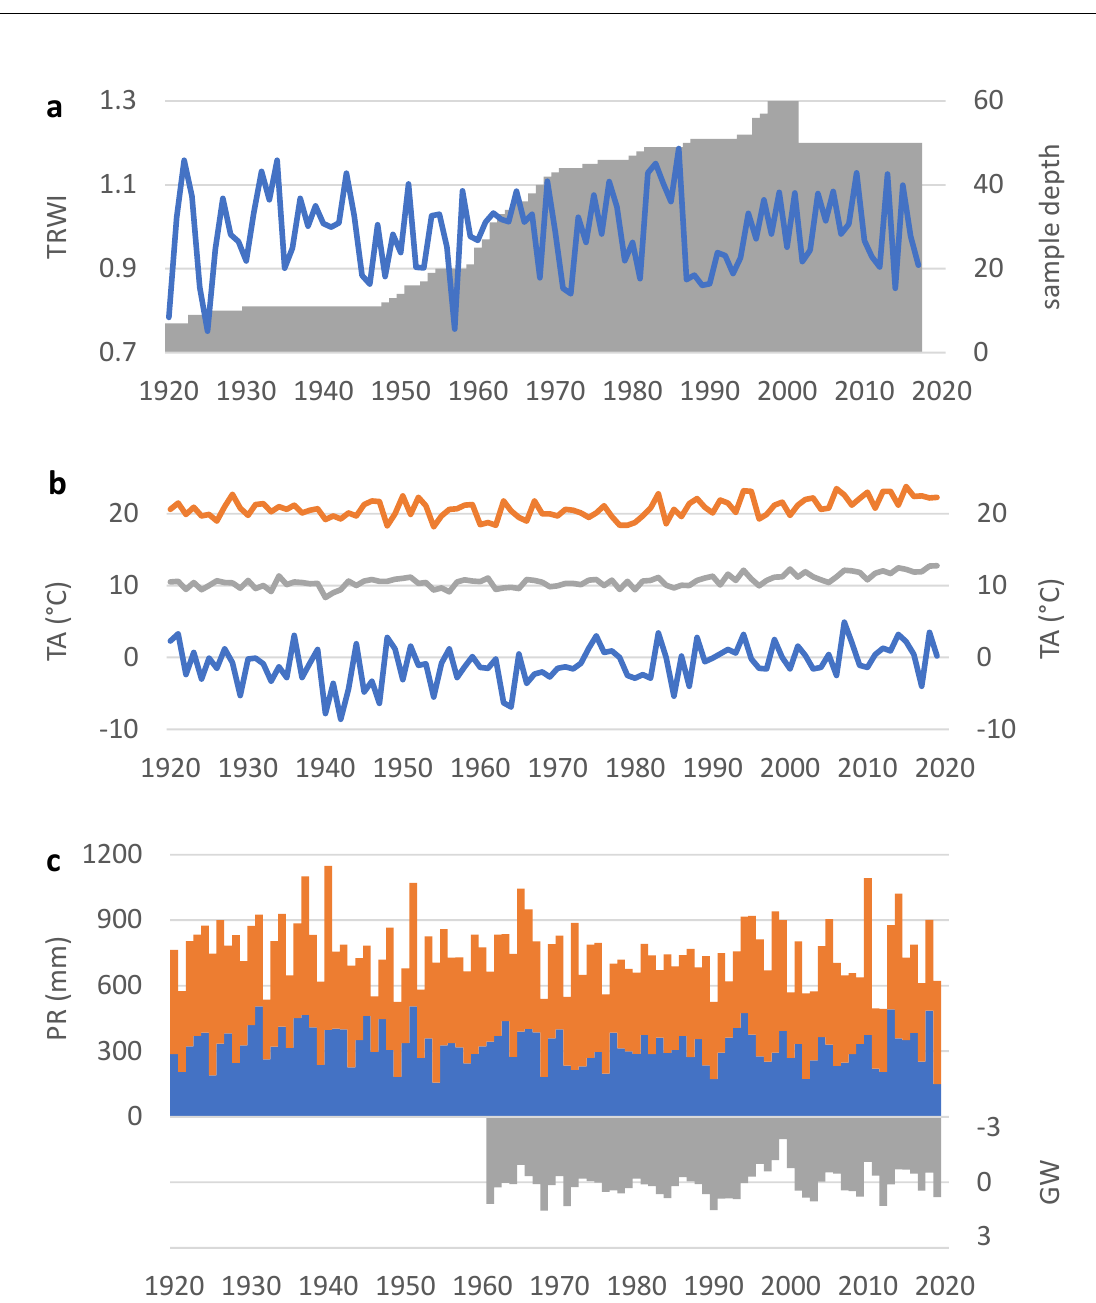
Figure 2. Mean detrended tree-ring width index chronology (TRWI) and its sample depth ( a ); January (blue), July (orange), and annual (gray) mean temperature (TA; CRU TS4.05) ( b ), and cumulated October–March (blue) and April–September (orange) precipitation sums (PR; GPCC V2020 analysis), as well as, normalized mean annual groundwater depth (GW; grey) ( c ), for the period of 1920–2019, with respect to data availability.